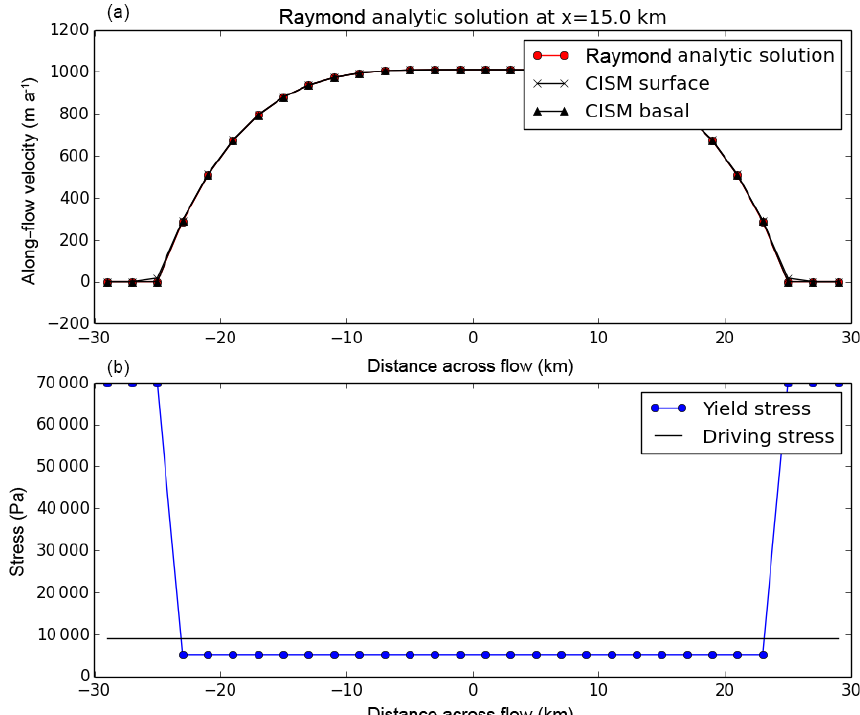
Figure 6. Results from the Raymond stream test using Glissade’s BP velocity solver. (a) Across-flow surface and basal velocity (myr − 1 ) at x = 15km compared to the analytic solution. At most points, the analytic and simulated solutions are indistinguishable. (b) Prescribed yield stress and gravitational driving stress